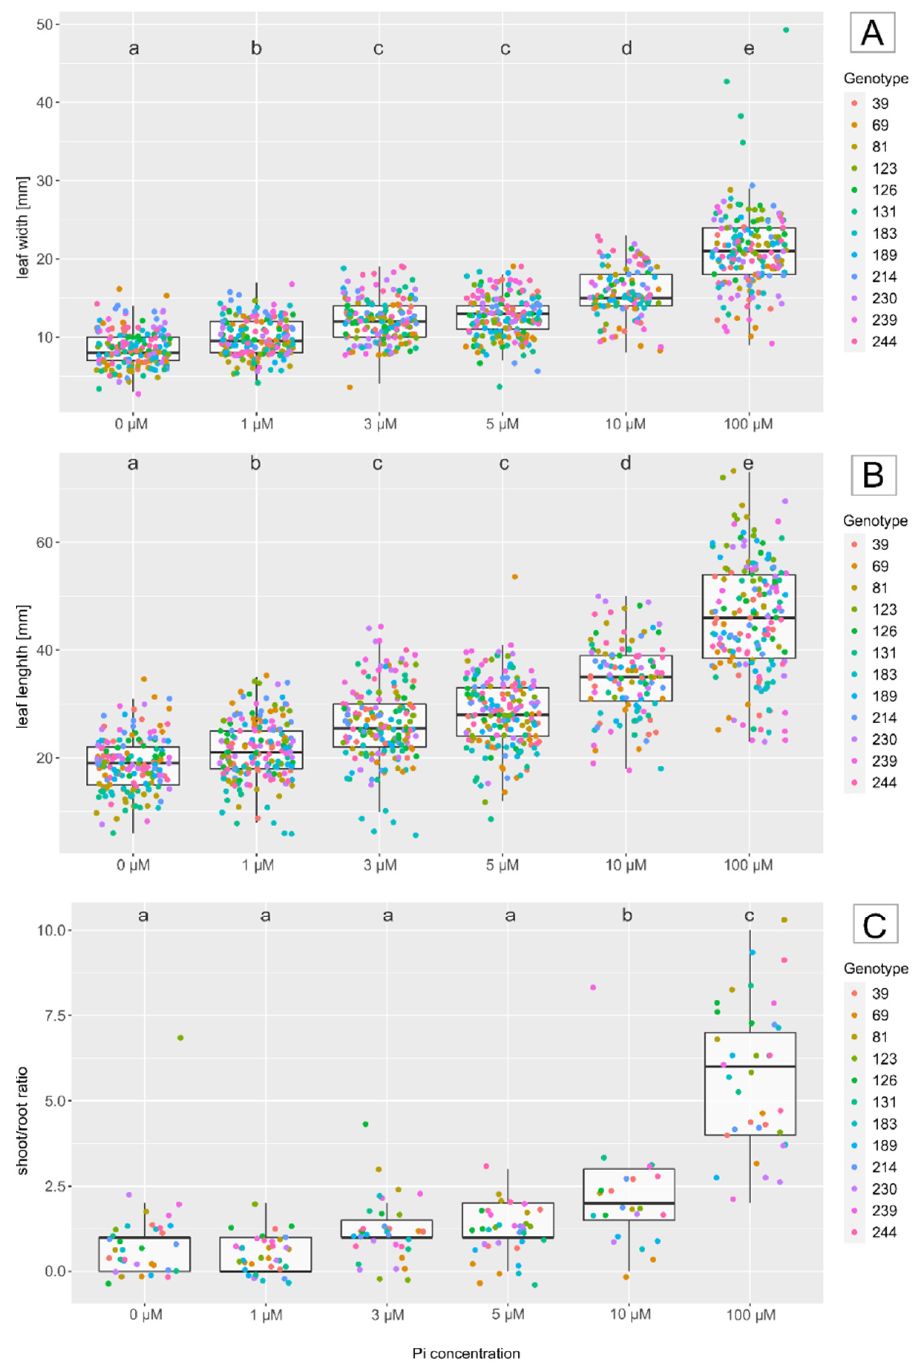
Figure 3. Boxplot of growth parameters of leaves. The leaf width (mm) ( A ), leaf length (mm) ( B ) and dry weight shoot/root ratio ( C ) under different P concentrations ( µ M) in the nutrient solution. Letters indicate significant differences between all treatments (Tukey test, Bonferroni adjusted).